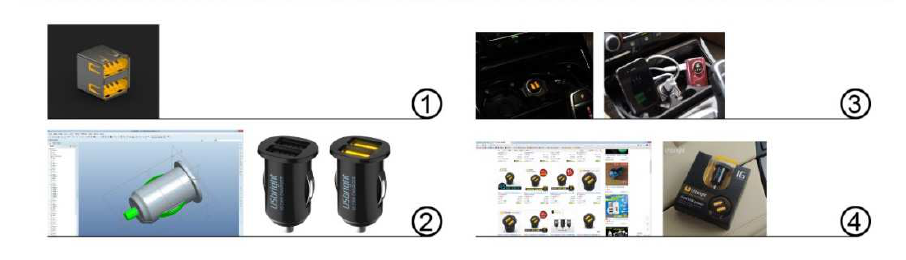
Figure 3: The 'IG', a Recent Developed Car Charger Product